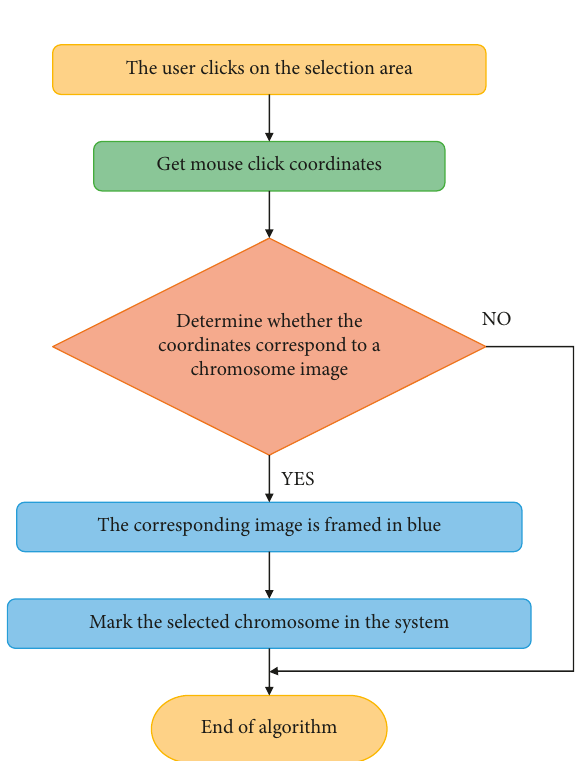
Figure 11: Selecting individual module